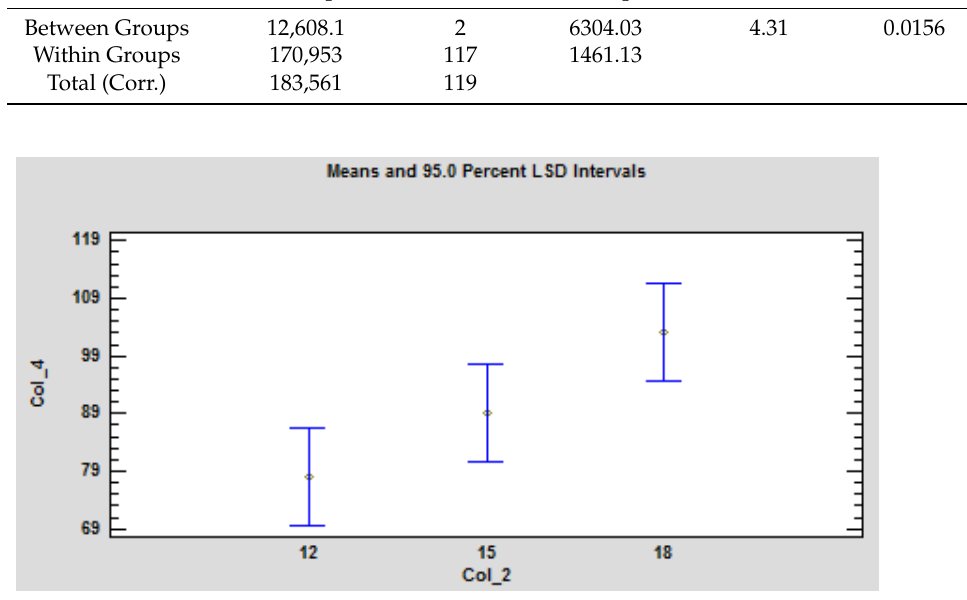
Figure 5. Graphical representation of the statistical evaluation of the influence of the board thickness on the ignition time under the action of the radiant heat source on the OSB. Legend: Col_2, thickness; Col_4, Time-to-ignition.